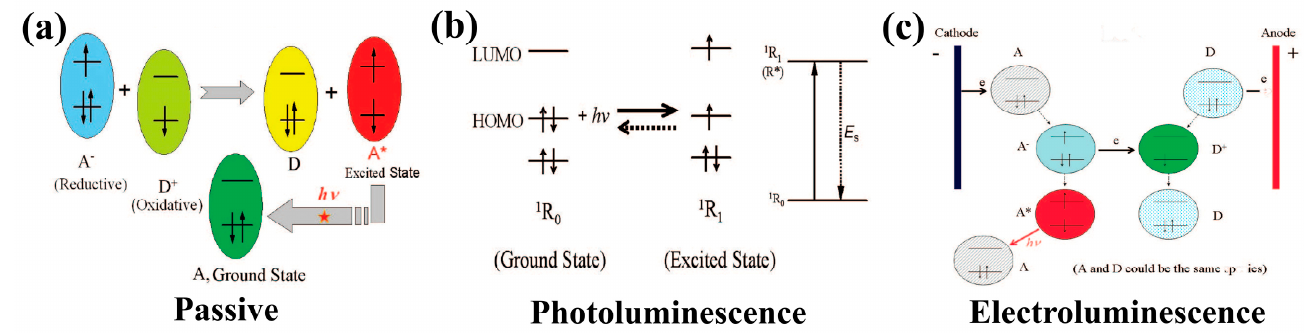
Figure 4. Schematic of the working principles for different types of optical biosensors: ( a ) Passive,